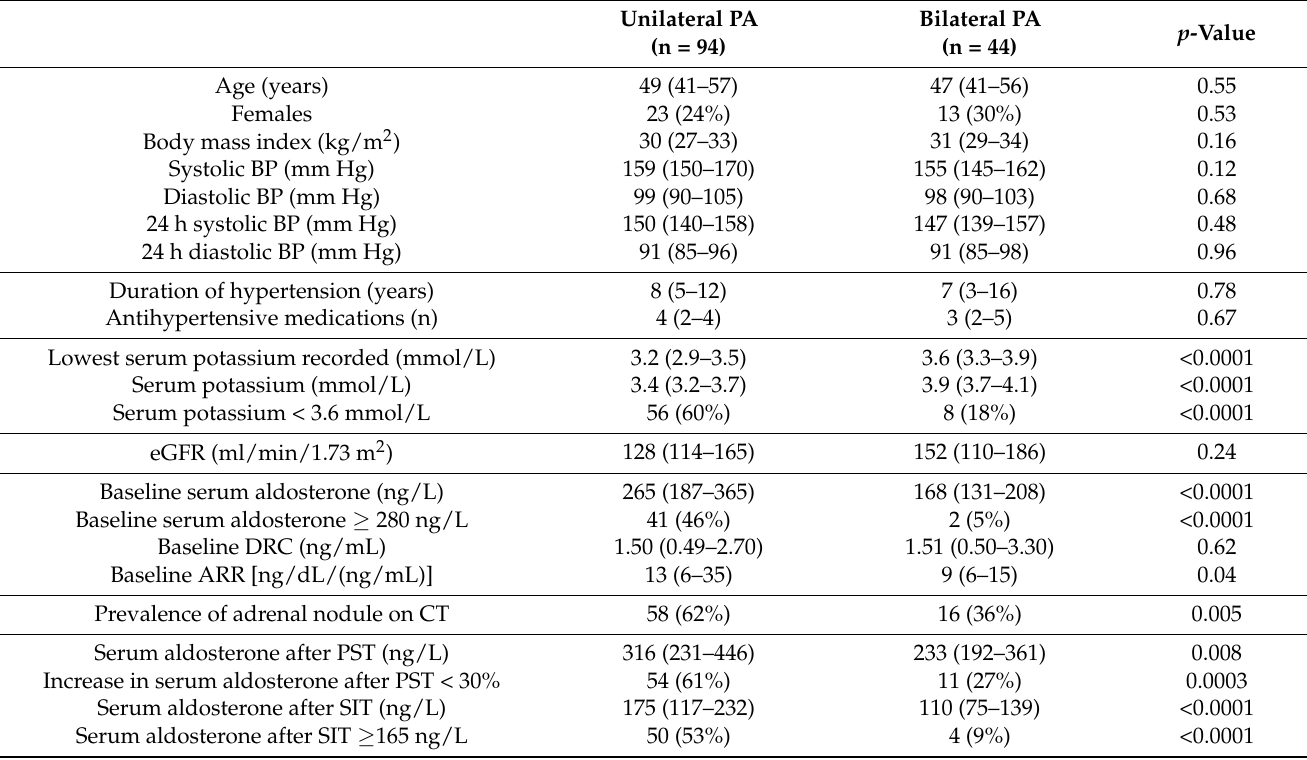
Table 5. Baseline characteristics of the validation cohort.